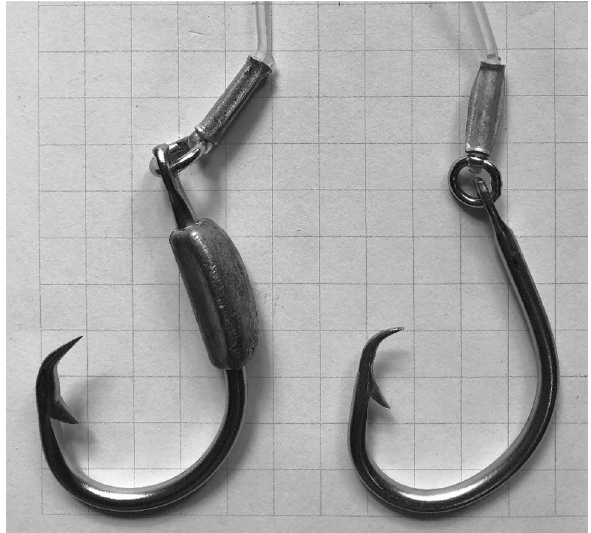
Figure 1. Control and experimental hooks. Squares have 1 cm length